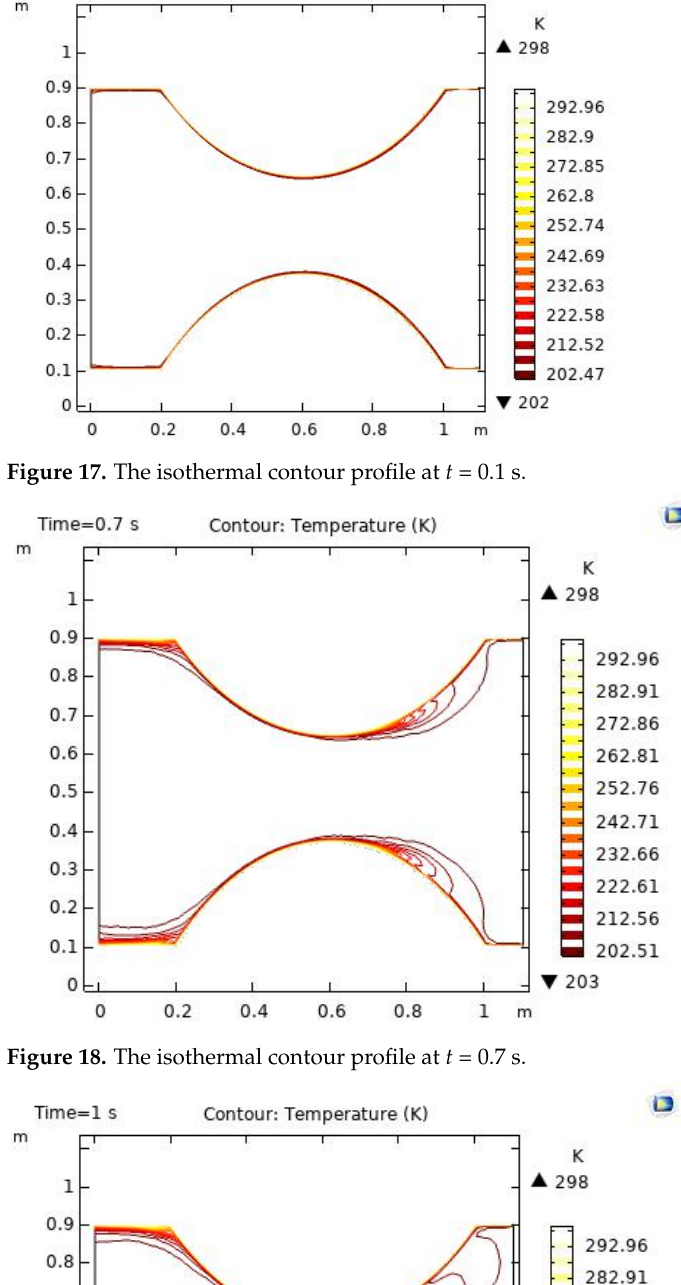
Figure 20. The streamlines at t = 0.1 s.